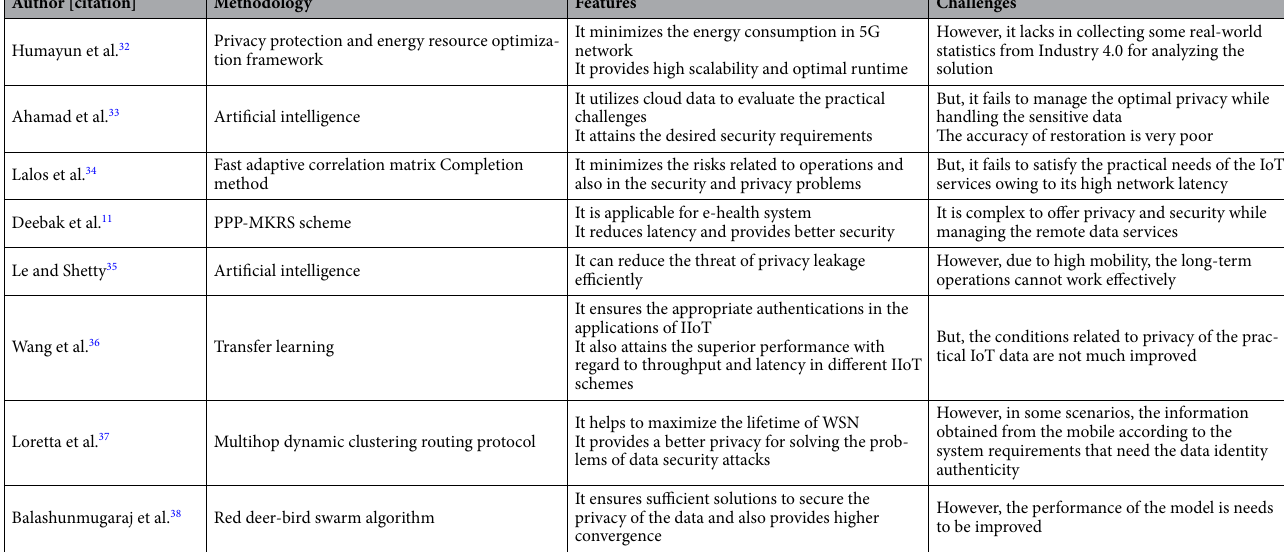
Table 1. Benefits and issues of privacy preservation using industrial